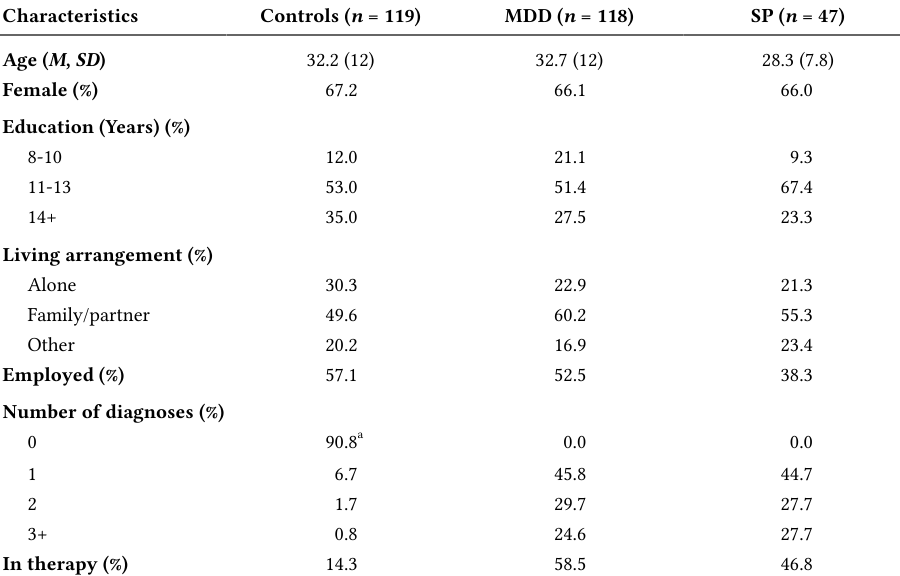
Sociodemographic and Clinical Characteristics of the Sample (N = 284)